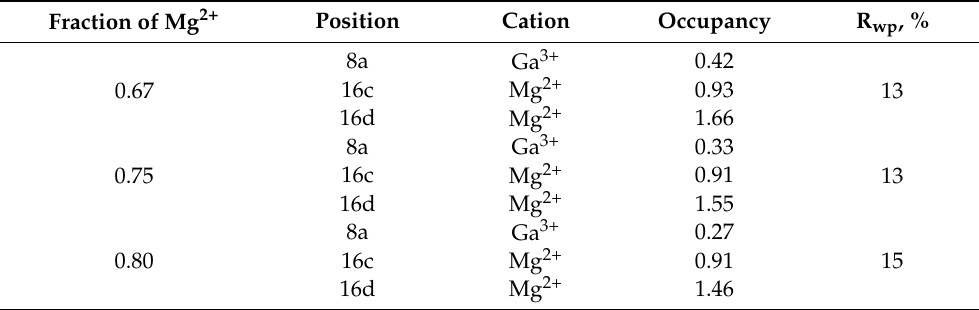
Table 2. Refinement of occupancies of the spinel positions 16d and 8a and non-spinel positions 16c in MgGa